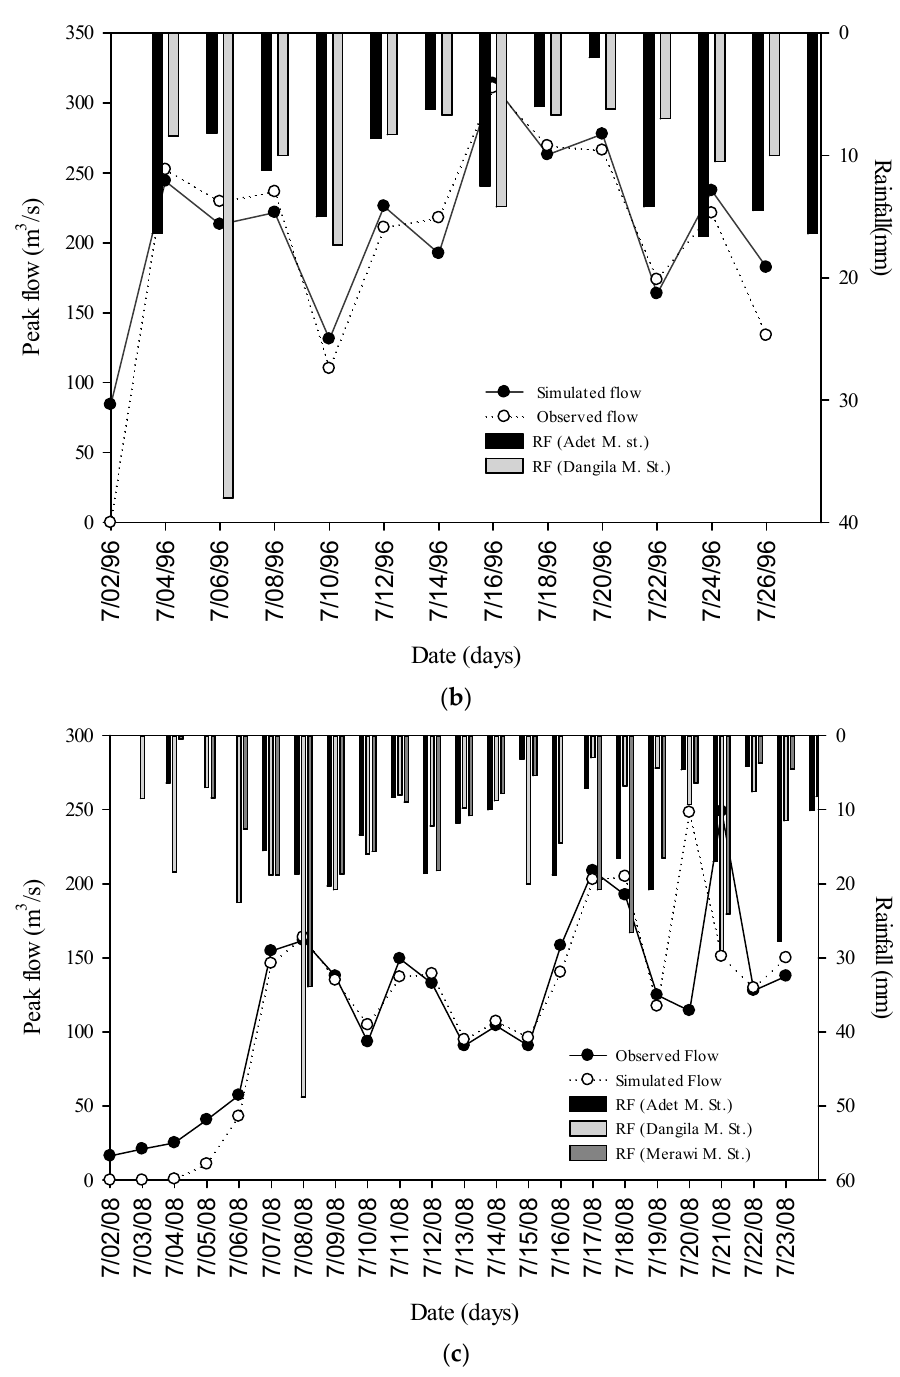
Figure 2. Comparison of simulated and observed hydrographs during calibration. ( a ) Model output for event 3 (14 July–02 August, 2006), ( b ) rainfall of contributing stations and simulated and observed hydrographs of Event 1 (02–26 July, 1996), and ( c ) rainfall of contributing stations and simulated and observed hydrographs of Event 6 (02–23 July,